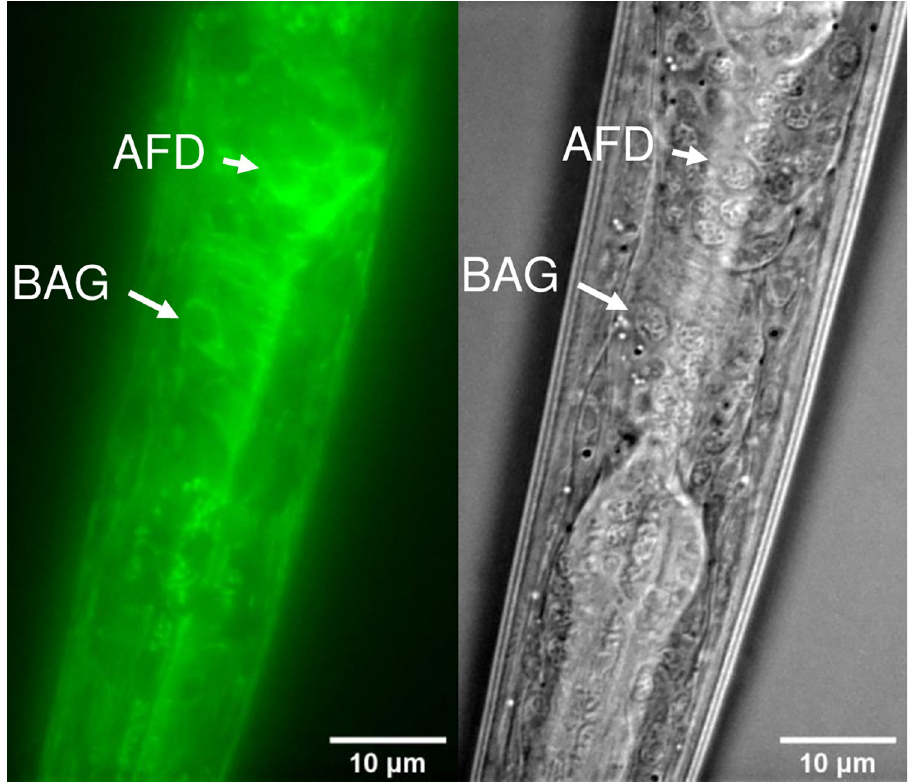
Fig 8. zyg-8 expression. A zyg-8(b235); njEx1680[zyg-8p :: zyg-8a cDNA :: GFP , ges-1p :: tagRFP] animal was subjected to microscopy for GFP fluorescence (left) and DIC (right)